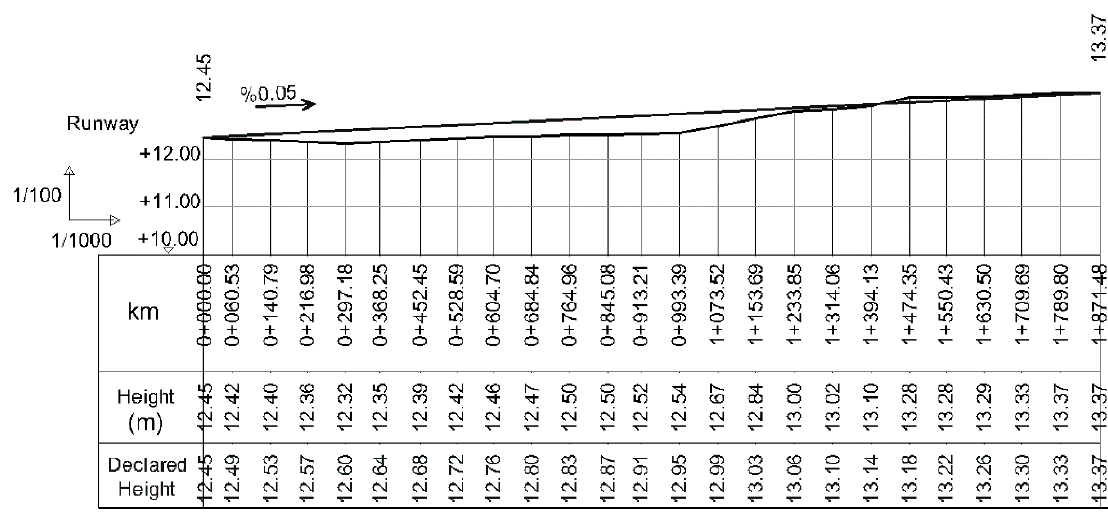
Figure 2. Leveled vs. declared centerline runway profile.